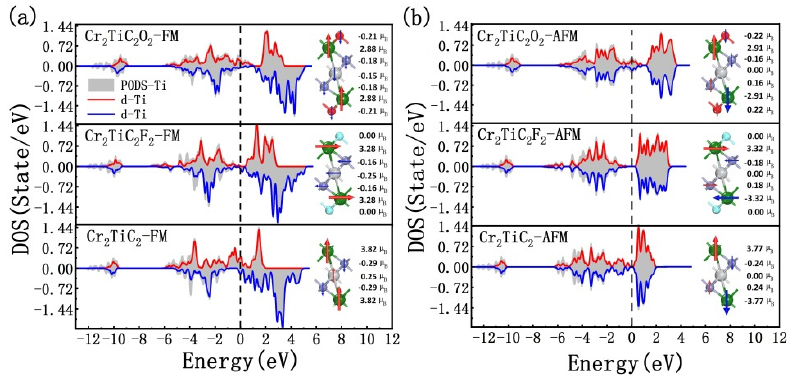
Figure 3. Projected density of states of Ti atoms and magnetic moments in the Cr 2 TiC 2 F 2 and Cr 2 TiC 2 O 2 structures with FM ( a ) and AFM1 ( b ) arrangements. Cr 2 TiC 2 O 2 structures with FM ( a ) and AFM1 ( b )